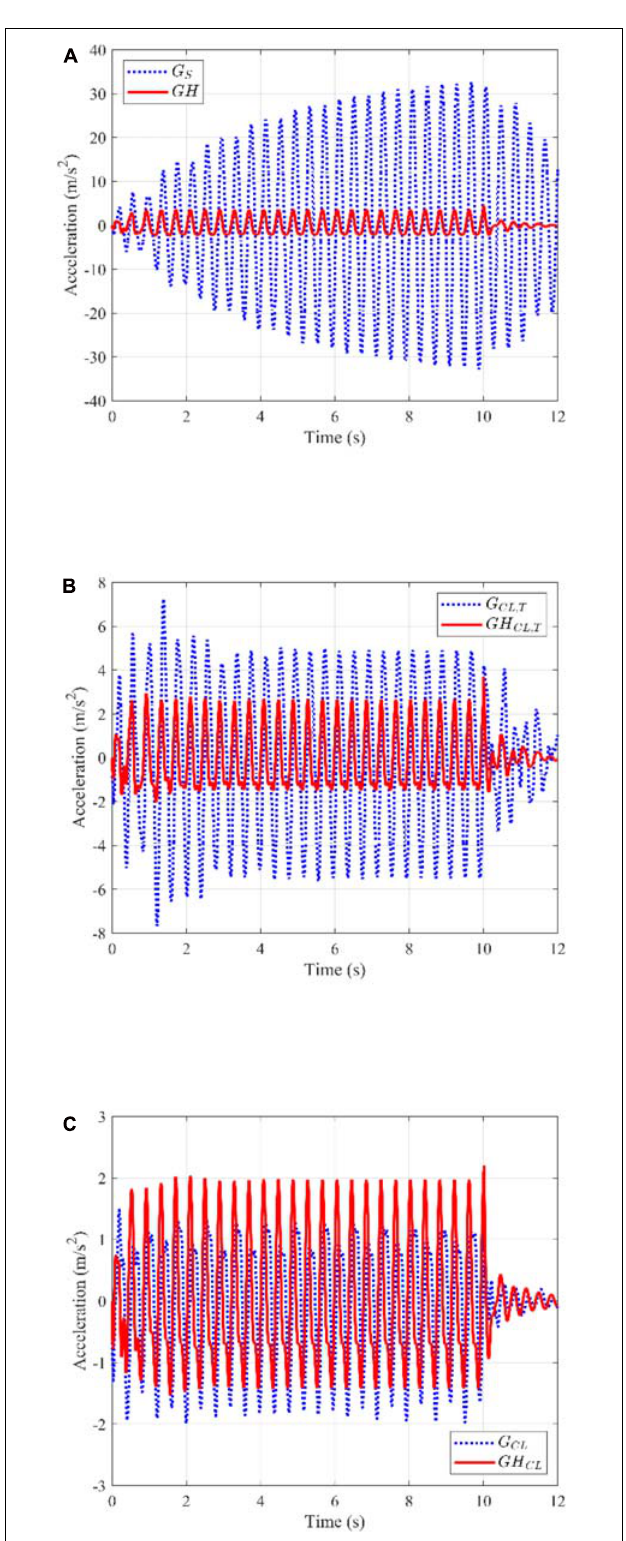
FIGURE 12 | Time history of acceleration response due to two people bouncing without and with HSI: (A) Uncontrolled plant, (B) Plant with a TVA system, and (C) Plant with an AVA